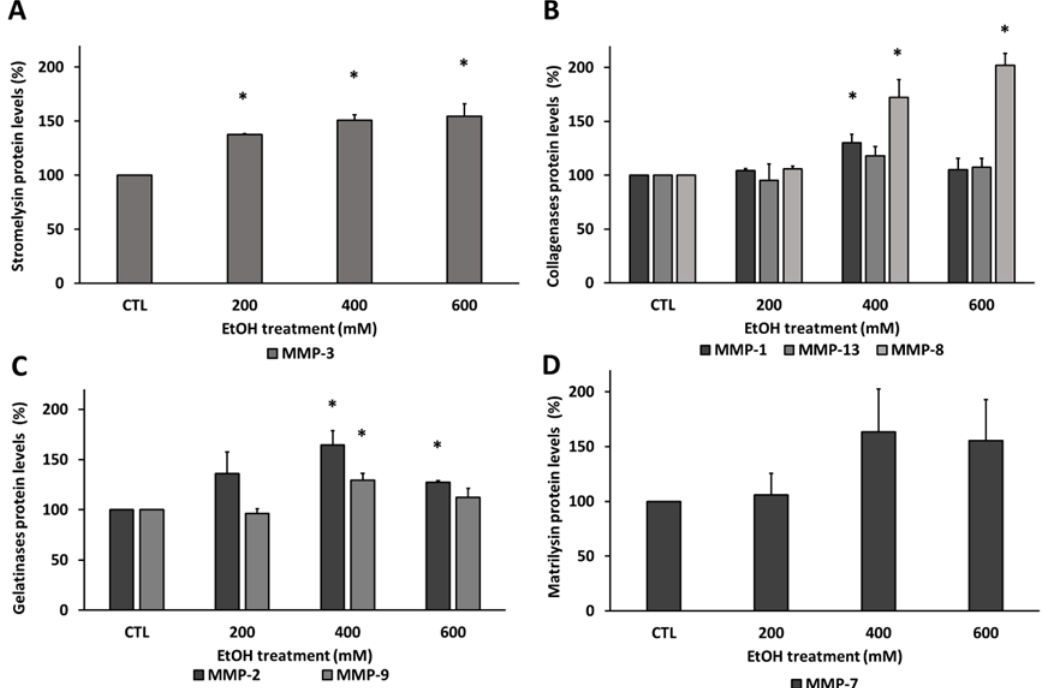
Figure 3. Metalloproteinase (MMP) protein levels in ARPE-19 cells under EtOH treatment. The levels of MMPs were measured with ELISA. The relative MMPs protein levels after EtOH treatment were represented by their functional classification: ( A ) stromelysin, ( B ) collagenases, ( C ) gelatinases and ( D ) matrilysin. Values are expressed as mean ± SEM (N = 3). Statistically significant differences were set at * p < 0.05 vs. CTL group.